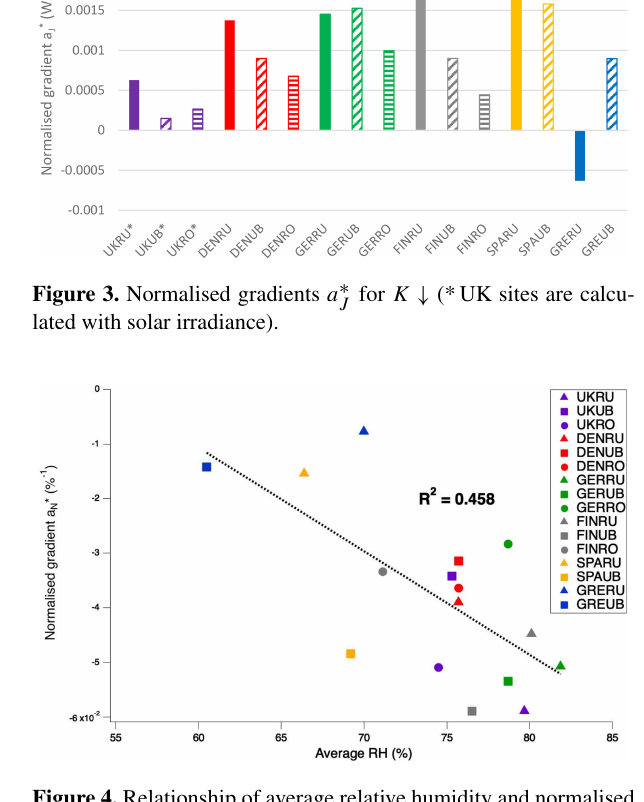
Figure 4. Relationship of average relative humidity and normalised gradients a ∗ N